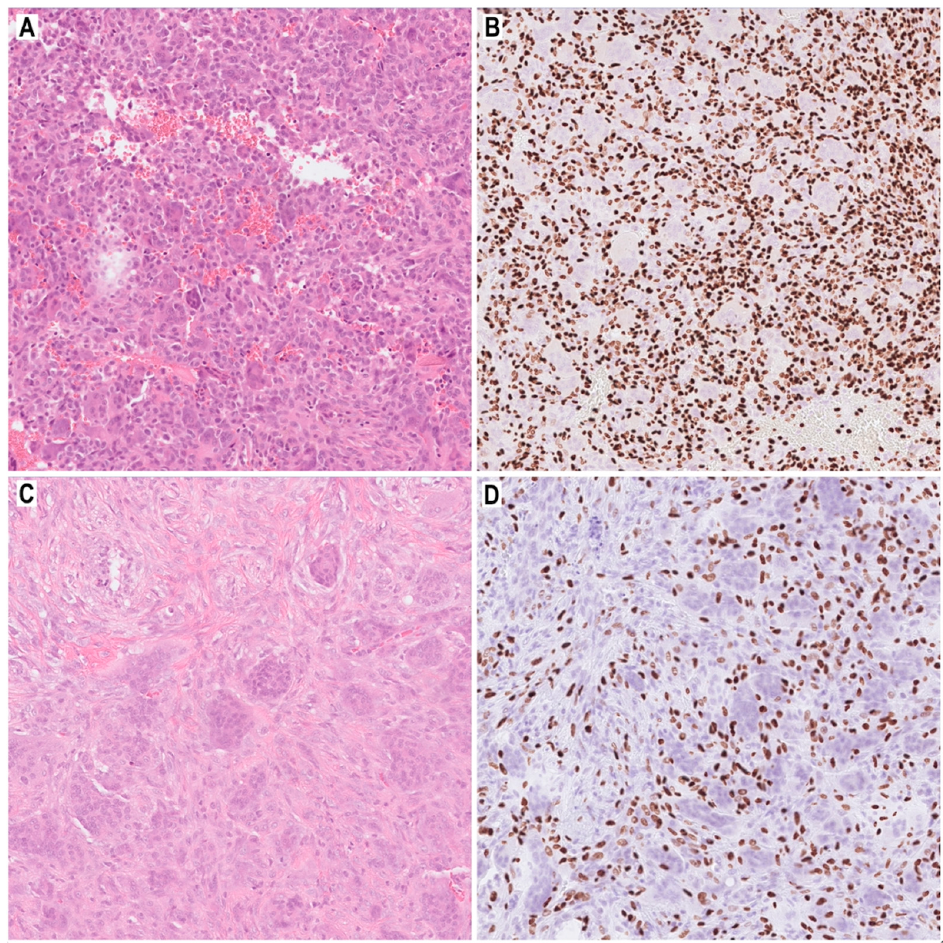
Figure 3. Giant cell tumor of bone: predominant mononuclear cells ( A , HE, 100×; B ) with strong nuclear expression of H3.3 p.Gly34Trp (G34W) ( B , G34W, 100×); the giant cells ( C , HE, 100×; D , G34W, 100×) are negative for H3.3 p.Gly34Trp (G34W) but positive reaction in mononuclear cells are described in over 90% of cases ( D , G34W, 100×).